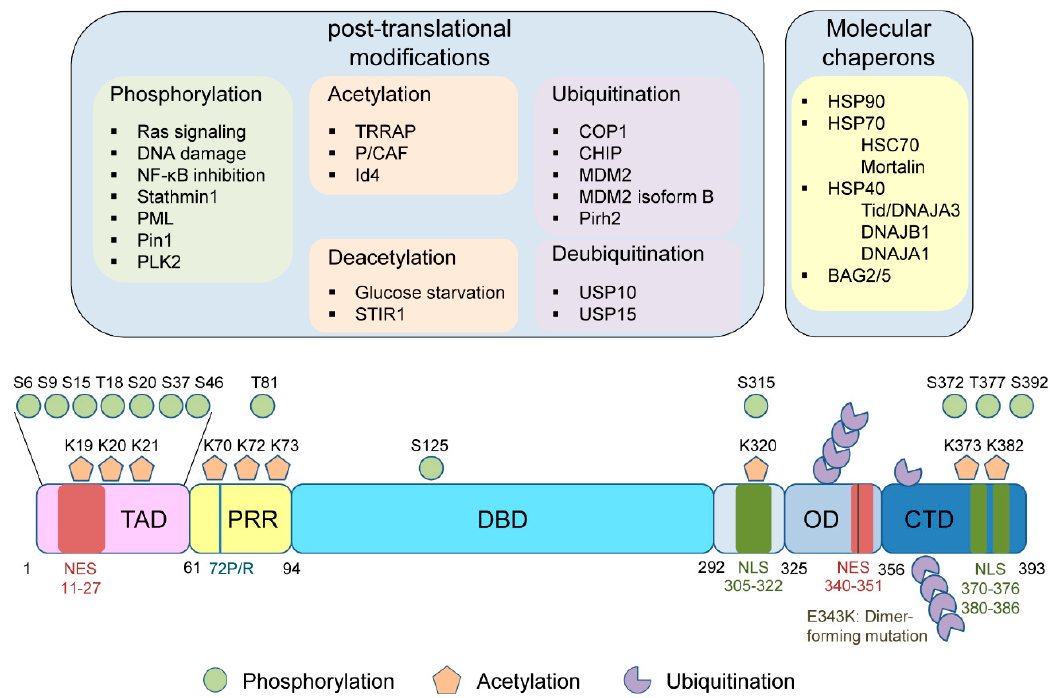
Figure 3. Upstream factors regulating mutant TP53 (mutp53) stability and activity, including post-translational modifications (PTMs) and molecular chaperones, as well as single nucleotide polymorphism 72 (SNP72) and dimer-forming mutations, in mutp53. TAD: Transactivation domain, PRR: Proline-rich region, DBD: DNA binding domain, NLS: Nuclear localization signal, OD: Oligomerization domain, NES: Nuclear export signal, CTD: C-terminal domain.